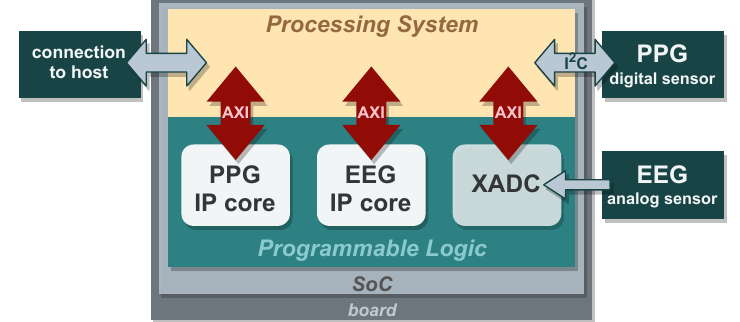
Figure 1. Proposed system